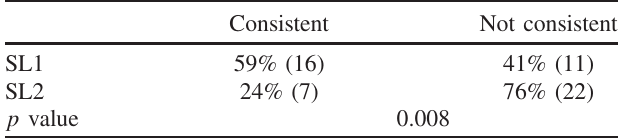
TABLE V. Percentages (and numbers) of students from the SL1 and SL2 groups who were consistent in all parts and p value for the comparison between the two groups via a chi-square